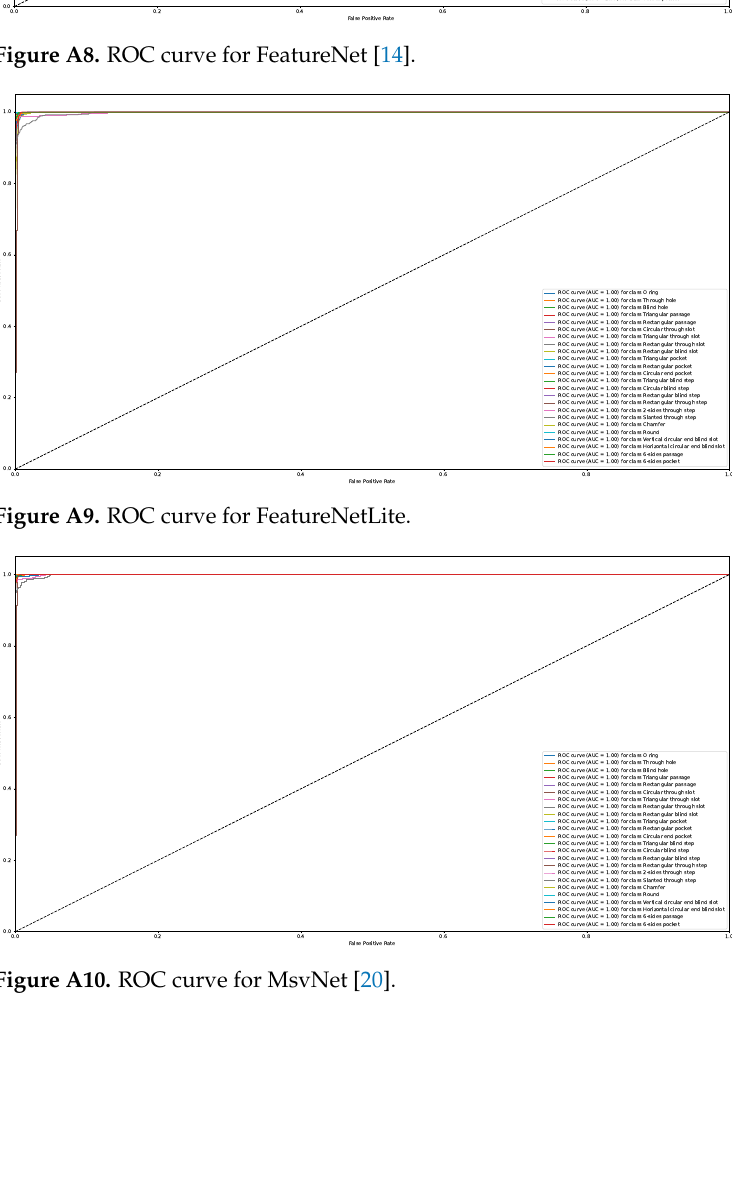
ROC curve (AUC = 1.00) for class O ringROC curve (AUC = 1.00) for class Through holeROC curve (AUC = 1.00) for class Blind holeROC curve (AUC = 1.00) for class Triangular passageROC curve (AUC = 1.00) for class Rectangular passageROC curve (AUC = 1.00) for class Circular through slotROC curve (AUC = 1.00) for class Triangular through slotROC curve (AUC = 1.00) for class Rectangular through slotROC curve (AUC = 1.00) for class Rectangular blind slotROC curve (AUC = 1.00) for class Triangular pocketROC curve (AUC = 1.00) for class Rectangular pocketROC curve (AUC = 1.00) for class Circular end pocketROC curve (AUC = 1.00) for class Triangular blind stepROC curve (AUC = 1.00) for class Circular blind stepROC curve (AUC = 1.00) for class Rectangular blind stepROC curve (AUC = 1.00) for class Rectangular through stepROC curve (AUC = 0.97) for class 2-sides through stepROC curve (AUC = 1.00) for class Slanted through stepROC curve (AUC = 1.00) for class ChamferROC curve (AUC = 1.00) for class RoundROC curve (AUC = 1.00) for class Vertical circular end blind slotROC curve (AUC = 1.00) for class Horizontal circular end blind slotROC curve (AUC = 1.00) for class 6-sides passageROC curve (AUC = 1.00) for class 6-sides pocket